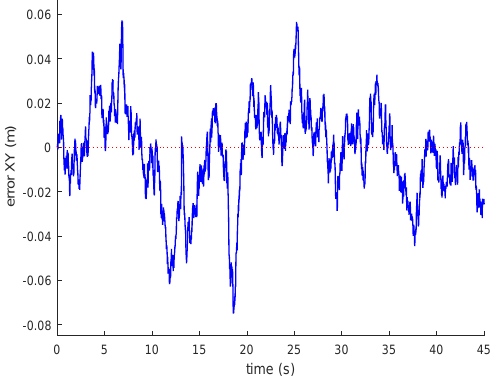
Figure 14. The trajectory offset of the